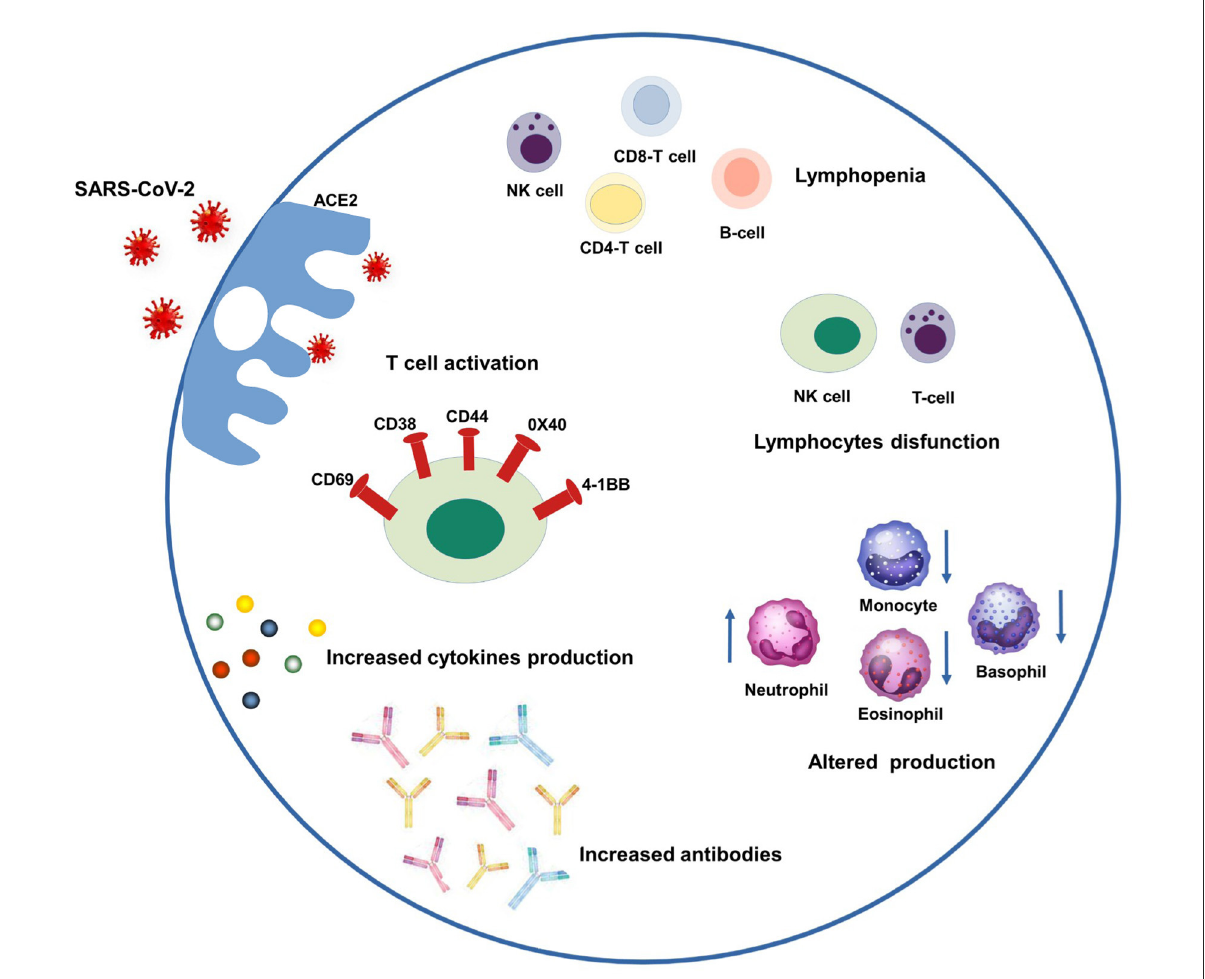
FIGURE1 Schematic representation of COVID-19 immune patterns. In the left-upper part of the scheme, SARS-CoV-2 enters the host’s cells through the ACE-2 specific receptor and triggering several patterns. Clockwise from the left they are: T cell activation through a high expression of CD69, CD38, and CD44, 0X40 and 4-1BB; lymphopenia including NK, CD4-T, CD8-T and B-cells; lymphocyte dysfunction including NK and T-cells; monocytes and granulocyte abnormalities (increased neutrophil levels, decreased eosinophil, basophil, and monocyte levels), increased amount of antibodies and